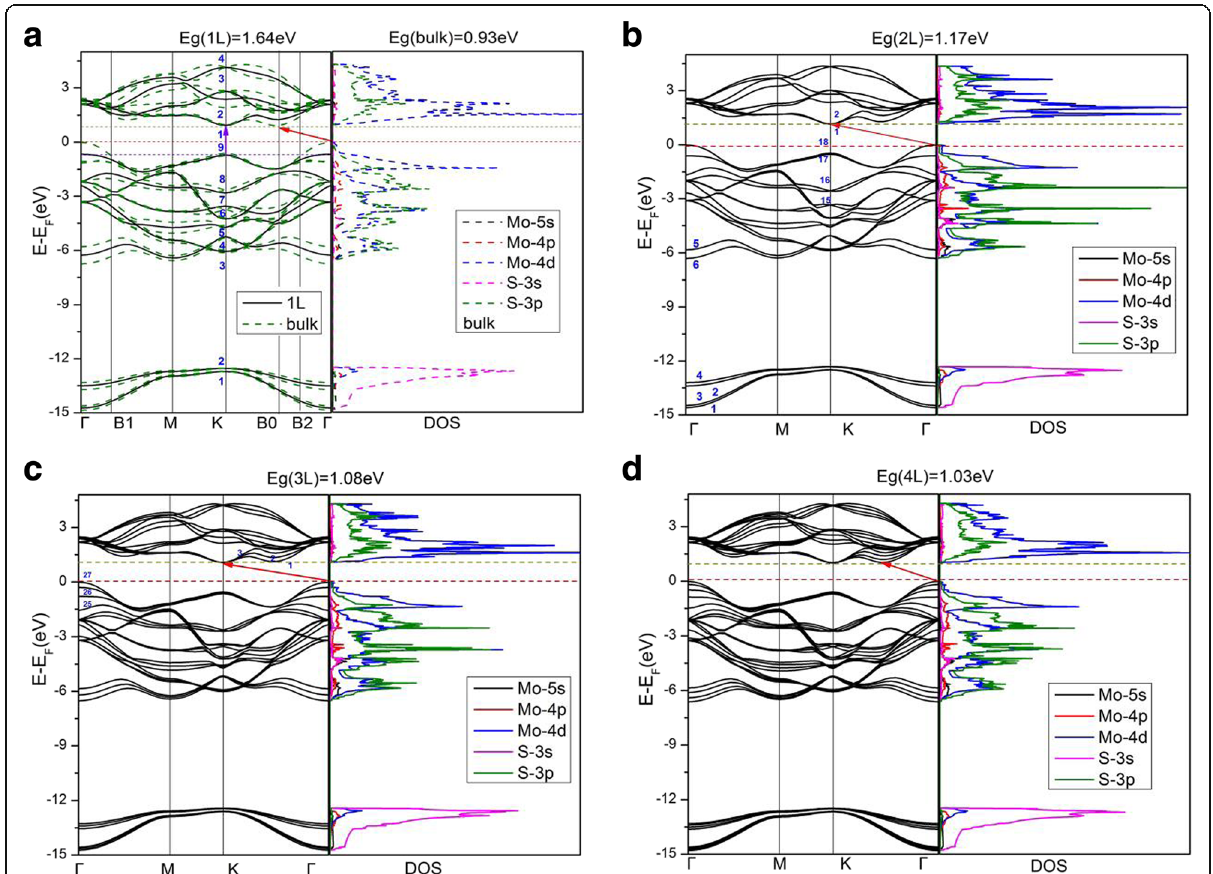
Fig. 3 Calculated band structures and density of states of a monolayer (full lines) and bulk (dash lines), b bilayer, c trilayer, and d four-layer MoS 2 . In a , the highest occupied bands for bulk and monolayer at point K are set to the same energy. Conduction band minimum of bulk is at point B0